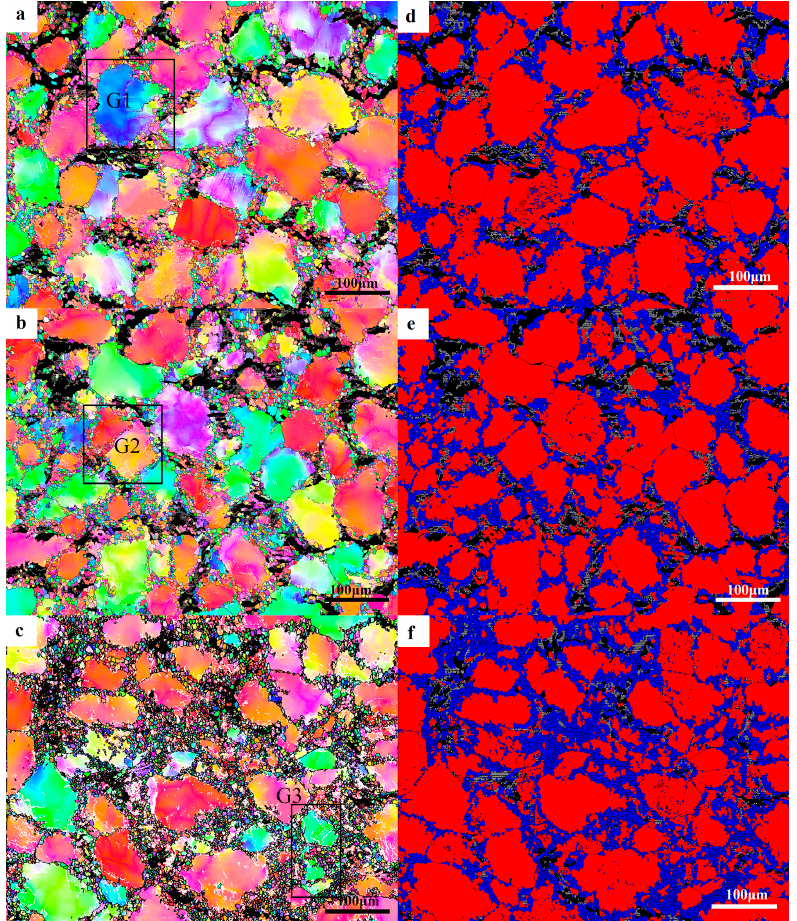
Figure 13. ( a – c ) The reverse pole figure of the center, middle, and edge of the strain rate of 0.1 s − 1 , respectively. ( d – f ) The corresponding recrystallizing diagrams, respectively .